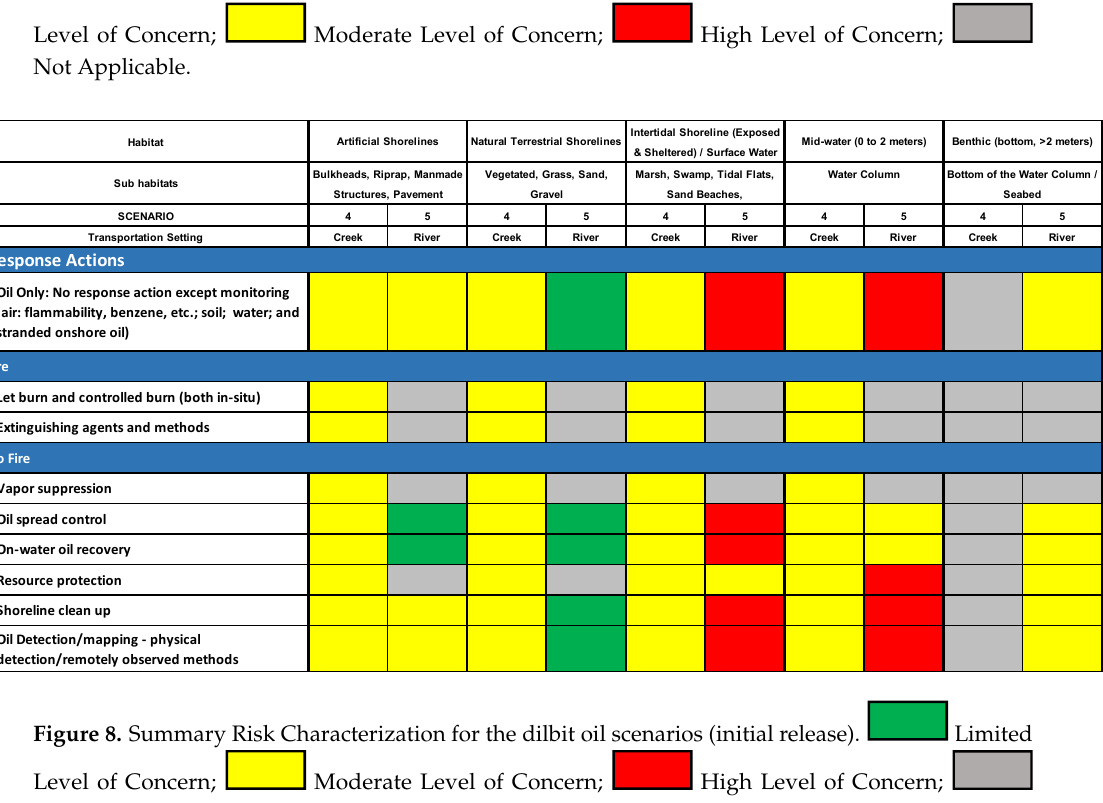
Figure 7. Summary Risk Characterization for the Bakken oil scenarios (initial release). Limited Level of Concern; Moderate Level of Concern; High Level of Concern; Not Applicable.